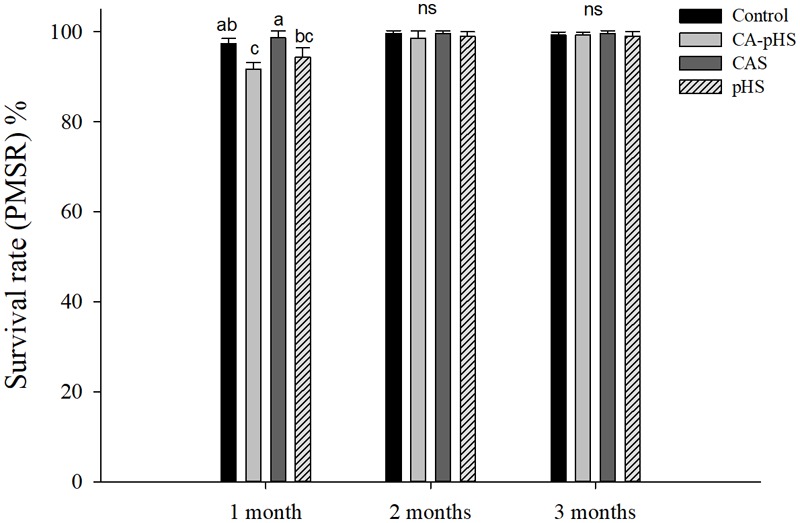
Juvenile of S. constricta per month survival rate in the long-term toxicity test. Bars (mean ± SE, n = 3) with different letters indicate significant differences (p < 0.05) among the four groups in each month. The letters “ns” indicate insignificant difference among the four groups in each month.